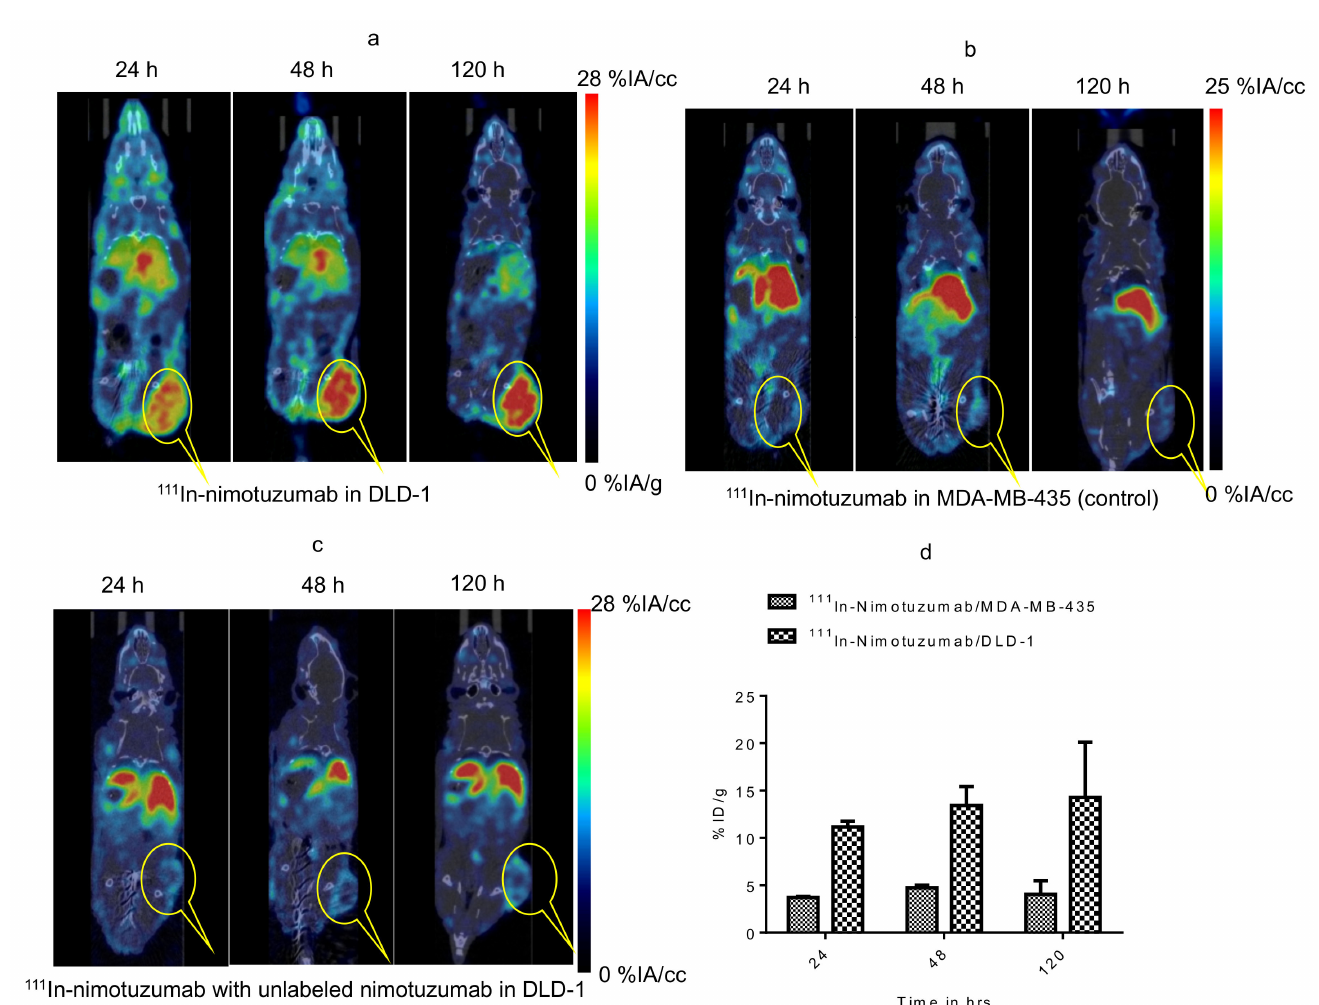
Figure 4. Micro SPCET/CT imaging of Domain III binding of 111 In-nimotuzumab in CD-1 nude mice bearing ( a ) EGFR positive DLD-1, ( b ) control MDA-MB-435 and ( c ) Pre-blocking with cold nimotuzumab followed by administration of 111 In-nimotuzumab and at 24, 48, and 120 h p.i. A group of mice was initially pre-injected with 250 µ g of unlabeled nimotuzumab to block domain III, and was followed by a tail vein injection of 111 In-nimotuzumab c (domain III specific). ( d ) Quantification of tumor uptake presented as %IA/g +/ −